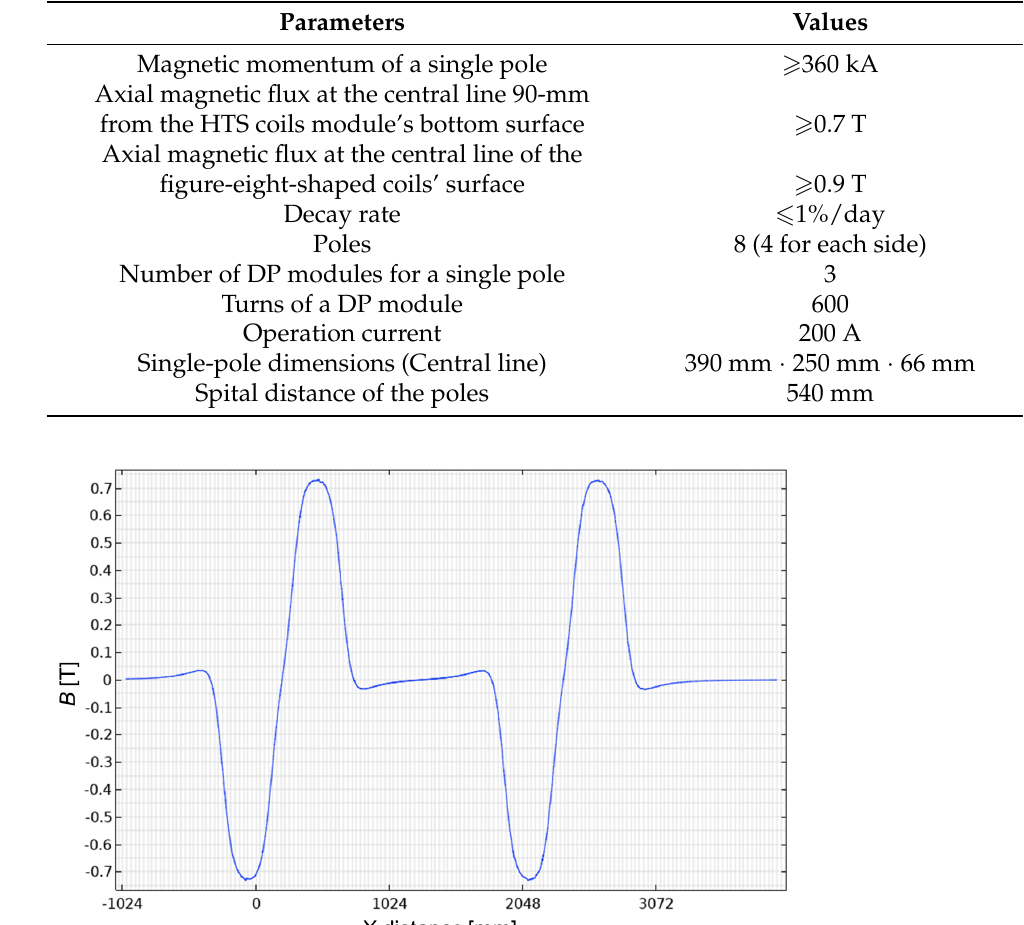
Table 1. Requirements of the EDS system and parameters of the HTS coils module.